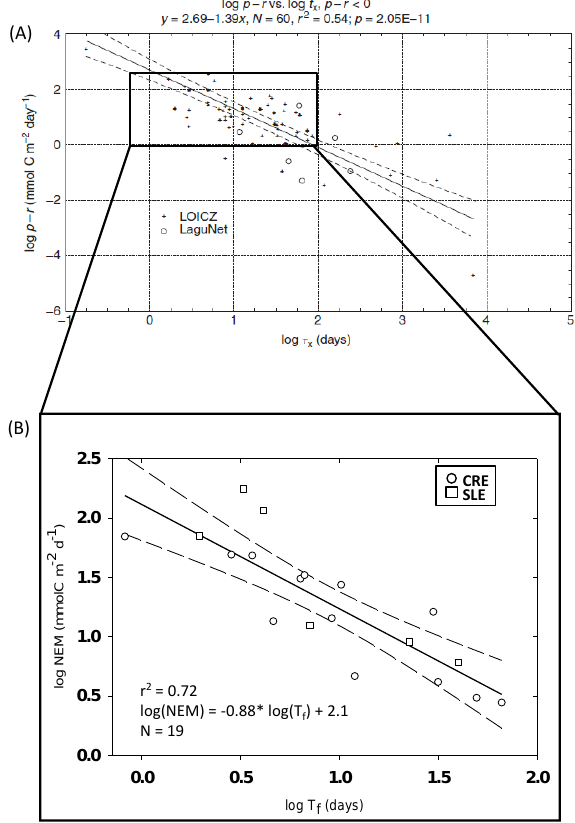
Fig. 11. Integrated results demonstrating the relationship between flushing time ( T f ; days) and NEM (mmol Cm − 2 d − 1 ) . (A) Plot of estuaries from the LOICZ database with negative NEM, adopted with permission from Swaney et al. (2011). (B) Similar results from the CRE and SLE confined to seasonal budgets with negative NEM (N CRE = 13; N SLE = 6). Values resulted from log transformation of the absolute values of NEM in each of the 19 cases. Provided are the linear regression information and 95% confidence intervals (dashed